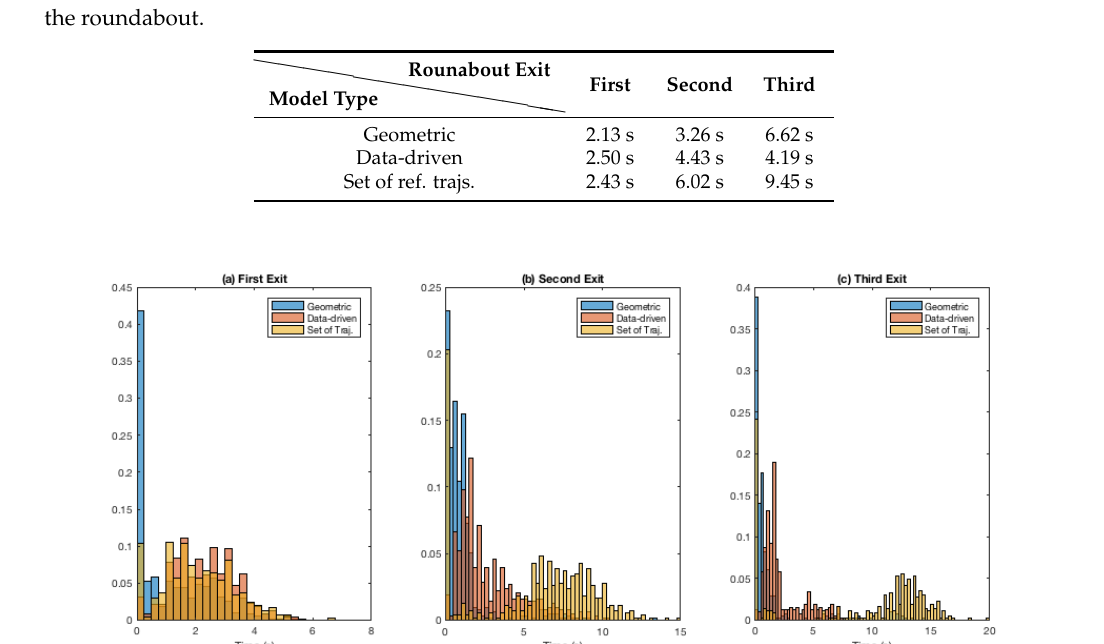
Figure 12. Exit-direction classification using feature set { x , y } . Normalised histograms for time since convergence: ( a ) first exit; ( b ) second exit; and ( c ) third exit. Note that the bin-size used for all the histograms is uniform, but the axes have been left non-uniform for